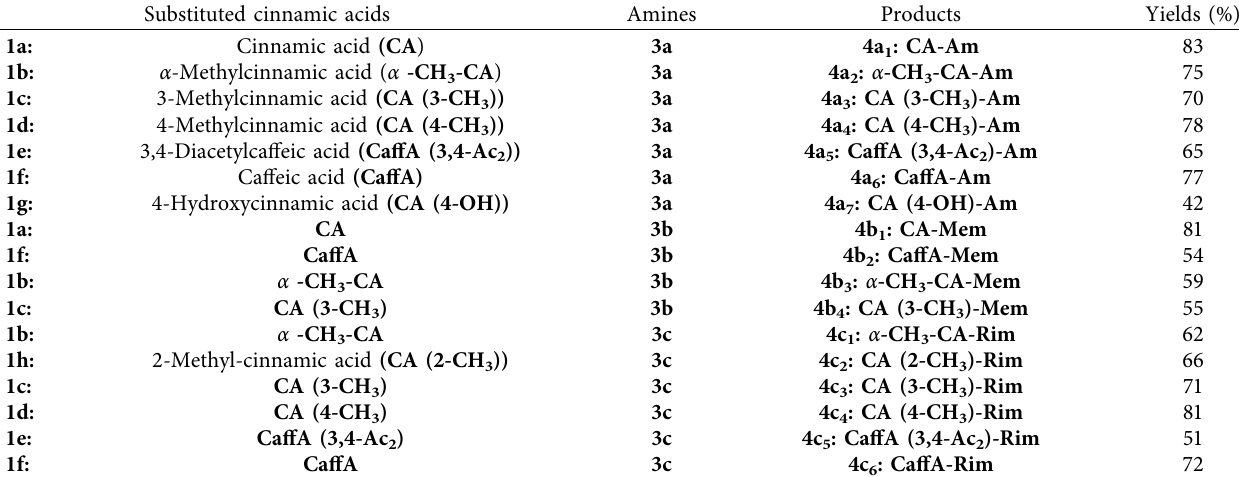
Table 1: Synthesized N -cinnamoyl adamantane amides. Substituted cinnamic acids Amines Products